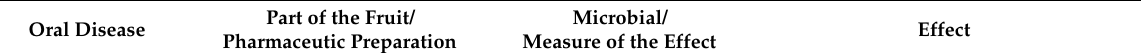
Table 3. Pharmacological effects of the fruits of P. granatum in oral